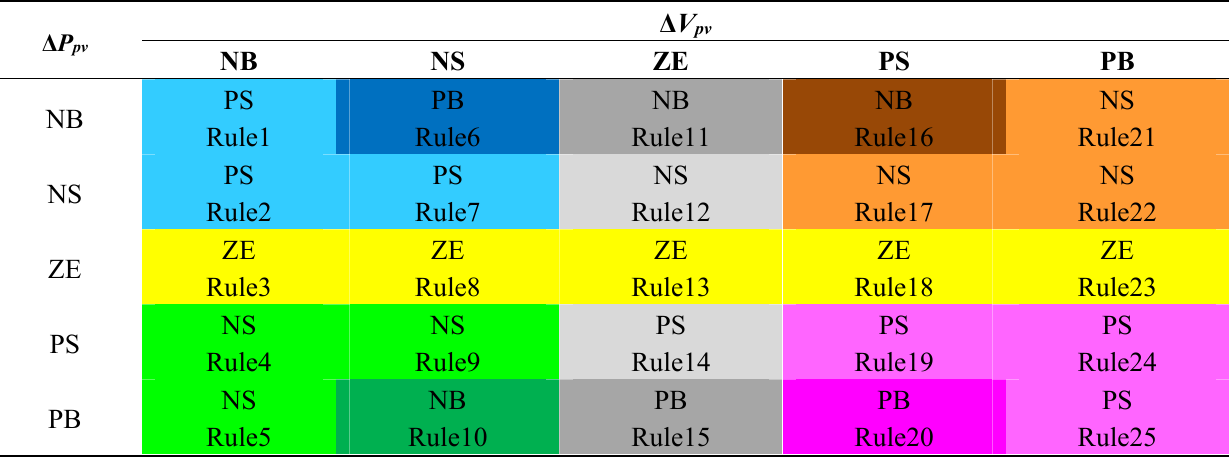
Figure 4. Block diagram of the implemented FLC-based MPPT controller. Table 1. Complete rule base for the proposed